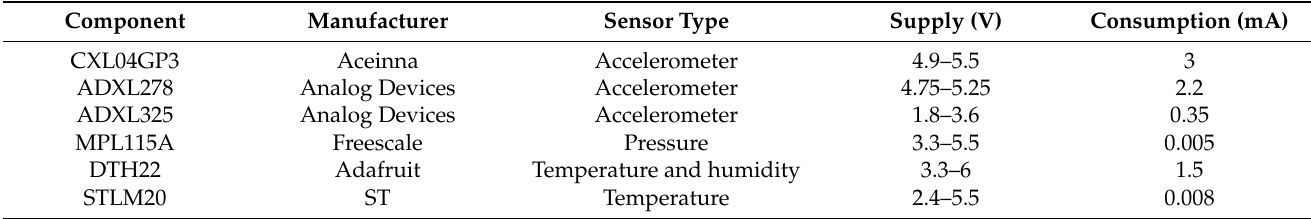
Table 4. Features of some commercialized MEMS sensors.